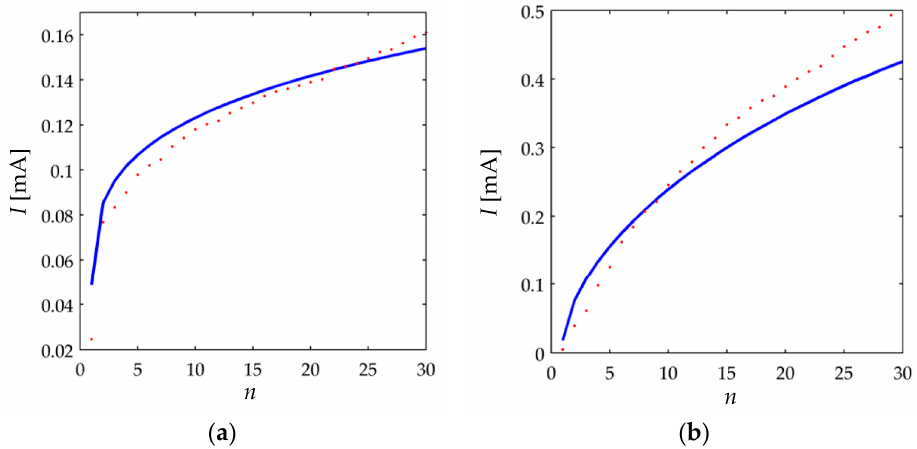
Figure 17. Test signal from Equation (47) exerted over the sensors: ( a ) FlexiForce A201-1 at V FSR = 3 V and ( b ) Interlink FSR 402 at V FSR = 2 V. Experimental data (red markers) and predicted current (solid blue) from Equations (39)–(41).